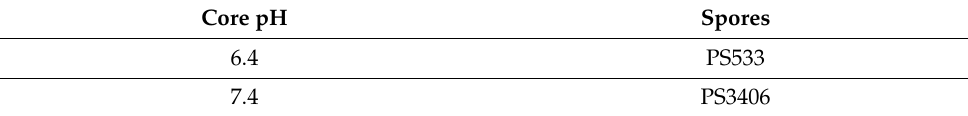
Figure 2. 14 C-Methylamine uptake by the intact spores of strains PS533 and PS3406. Methylamine uptake was measured, as described in the Methods section, and the values have been corrected to compare the uptake via an identical number of spores. The symbols used are PS533— and PS3406— . Table 1. Core pH in spores of several strains *.